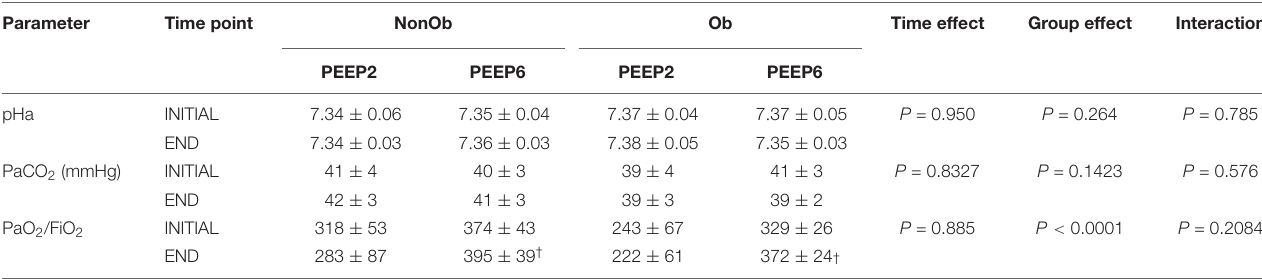
TABLE 1 | Arterial blood gases.